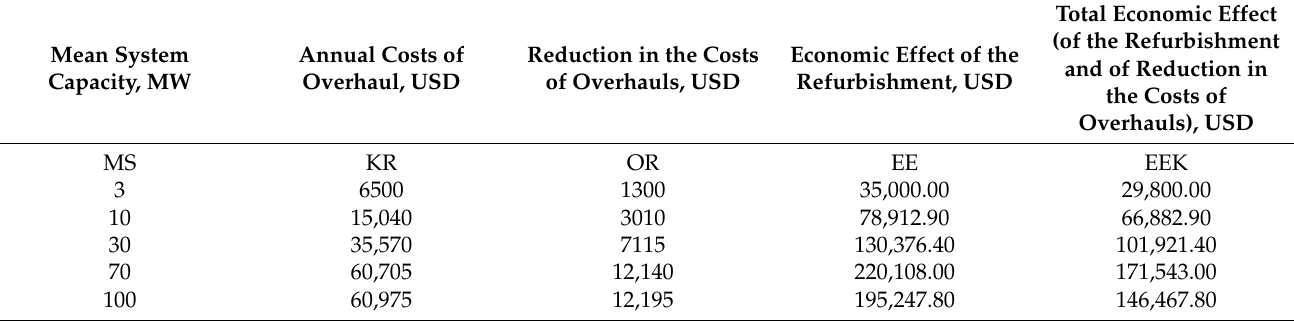
Table 5. The economic effect of the use of the catalyst and reduction of the costs of overhaul.